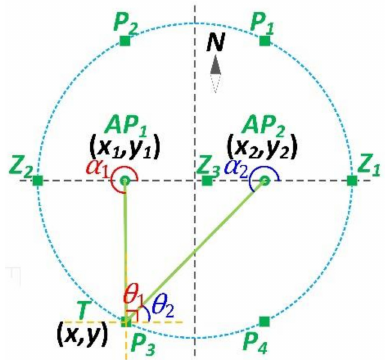
Figure 3. Special cases of the target’s